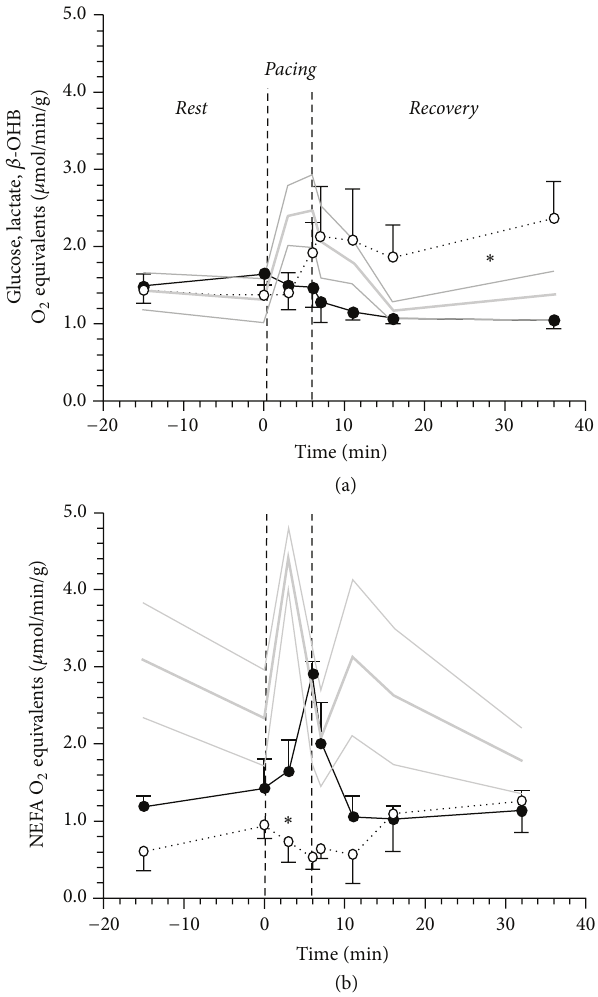
Figure 3: Cardiac energy generation expressed on oxygen equivalents from (a) small molecules, blood born, readily oxidizable substrates (calculated summing up glucose, lactate, and 𝛽 -OH-butyrate net balances and assuming their full oxidation) as compared to energy generated by NEFA oxidation as measured from [9,10 3 H]-oleate conversion to 3 H 2 O in 5 N-AGT (gray line), 4 DCM-NGT (dotted black line), and 4 DCM-AGT (continuous black line) in the 3 phases of the study protocol: Rest , Pacing , and Recovery . The plotted values are mean ± SEM. The thin gray lines represent the SEM of the N-AGT group. ∗ indicates a 𝑝 < 0.05 for the comparison between DCM-AGT and DCM-NGT over the study phase by 2-way ANOVA for repeated